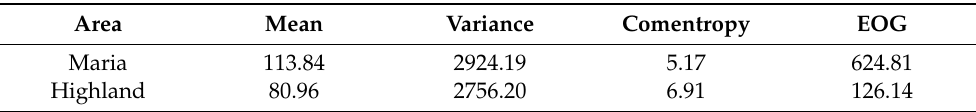
Table 3. Quality Evaluation of DOM in Maria and